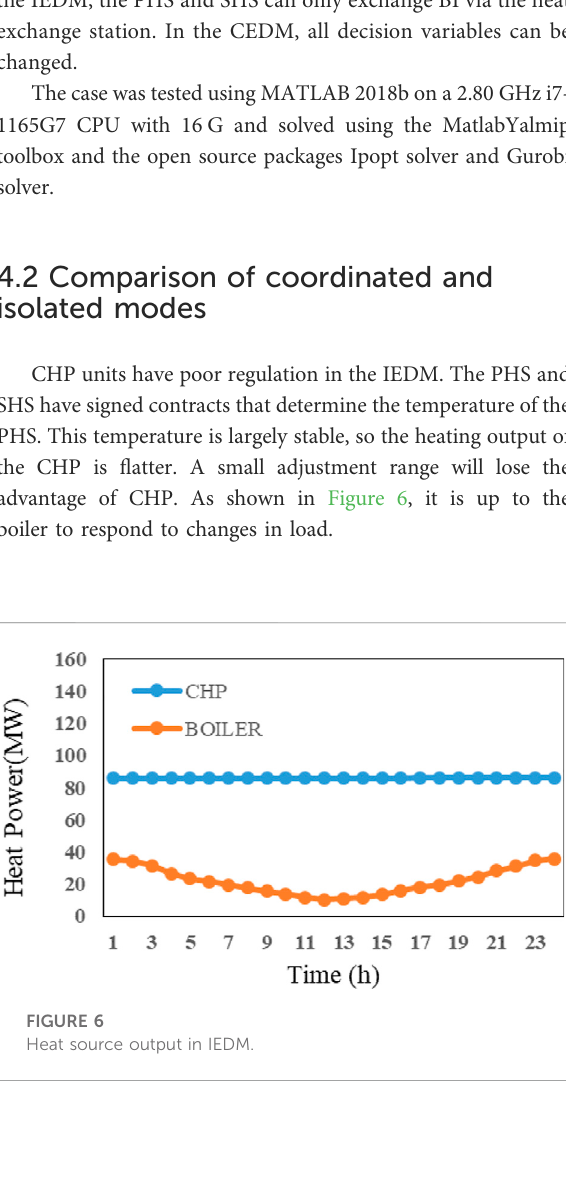
FIGURE 5 Diagram of the F6S12